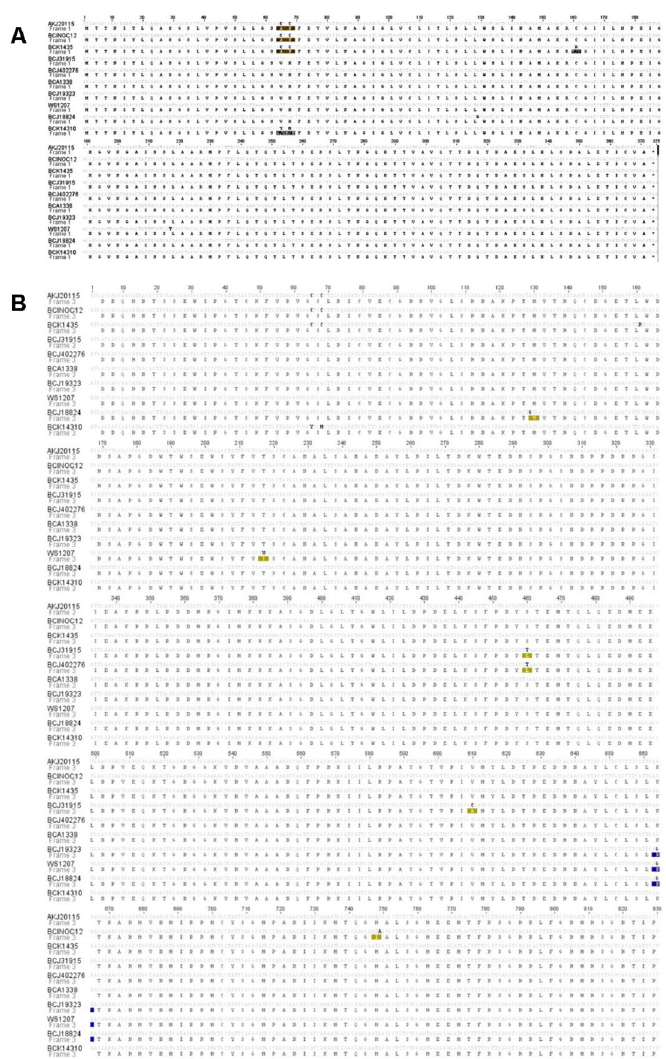
Fig 2. Alignment of the 10 different types of Piscine reovirus partial segment S1 and ORF p13 nucleic acid and amino acid sequences derived from fish tissues collected in the Canada/US Pacific area (see Table 1 for sample identification). Ten distinct sequence types were identified from 71 fish samples. A/ Nucleic acid sequences encoding for protein p13. B/ Partial segment S1 nucleic acid sequences encoding for protein σ 3. Grey codes represent conserved nucleotides whereas black letters indicate nucleotide substitutions. Amino acid substitutions are